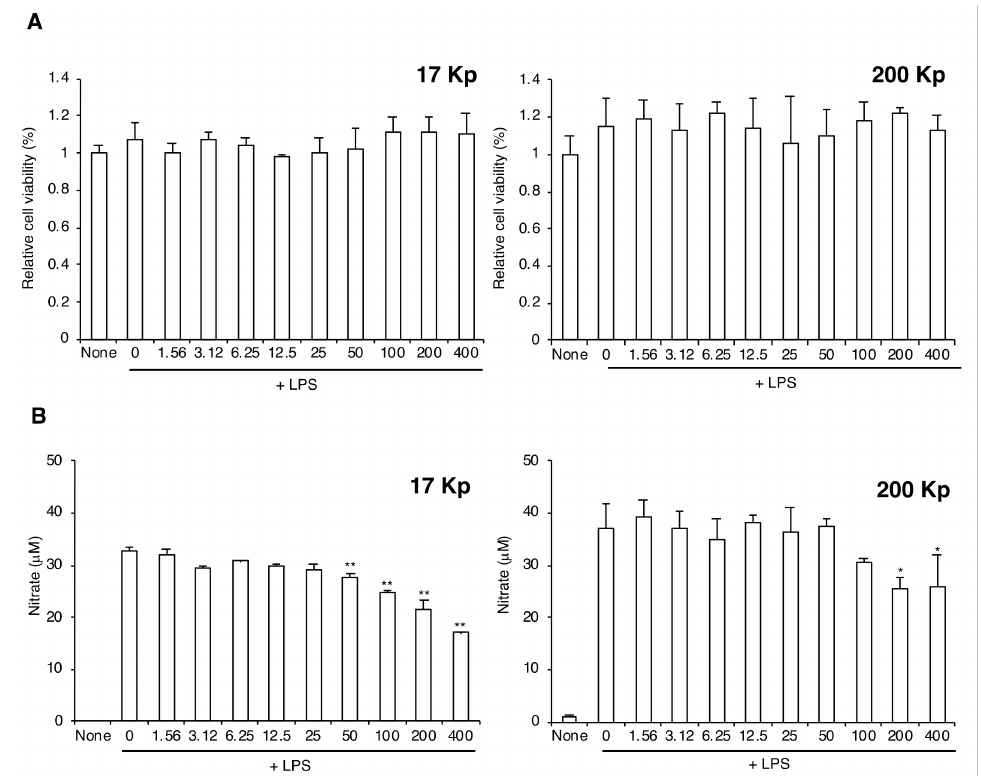
Figure 2. Effect of 17 Kp and 200 Kp on the nitric oxide production in lipopolysaccharide (LPS)- treated RAW264 cells. Cell were treated with 17 Kp or 200 Kp for 24 h then treated with or without LPS (100 ng/mL) for 24 h. ( A ): Cytotoxicity was evaluated by using Cell Counting Kit-8, and data are shown as relative cell viability (data in none were shown as 1). ( B ): Nitric oxide was detected as nitrate by Griess method. Data are means ± SE for 3 experiments. Asterisk indicates significant difference from the 0 + LPS group at * p < 0.05, ** p <